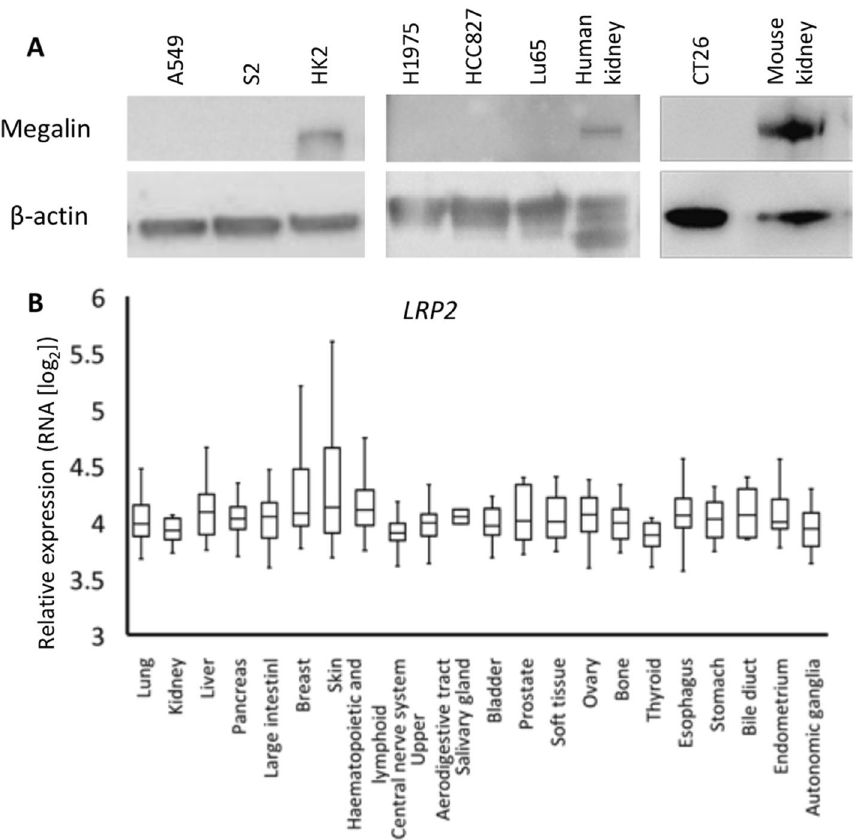
Figure 2. Megalin is not expressed in cancer cell lines. ( A ) Megalin expression in human lung cancer cell lines, a mouse colon adenocarcinoma cell line, human kidney lysate and mouse kidney lysate was determined by western blotting. The representative plots of 3 different experiments are shown. ( B ) mRNA expression of LRP2 (encoding megalin) in various cancers from the CCLE database. Normalized expression from the microarray data was calculated by robust multichip analysis